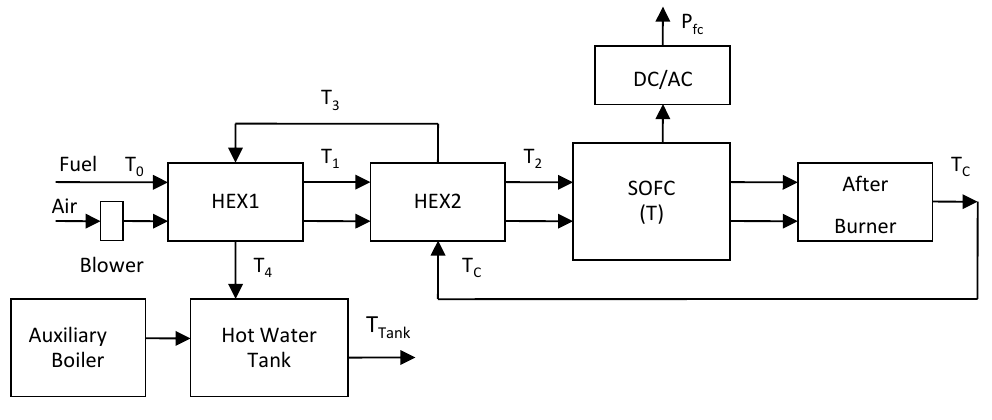
Figure 2. Micro-CHP System model